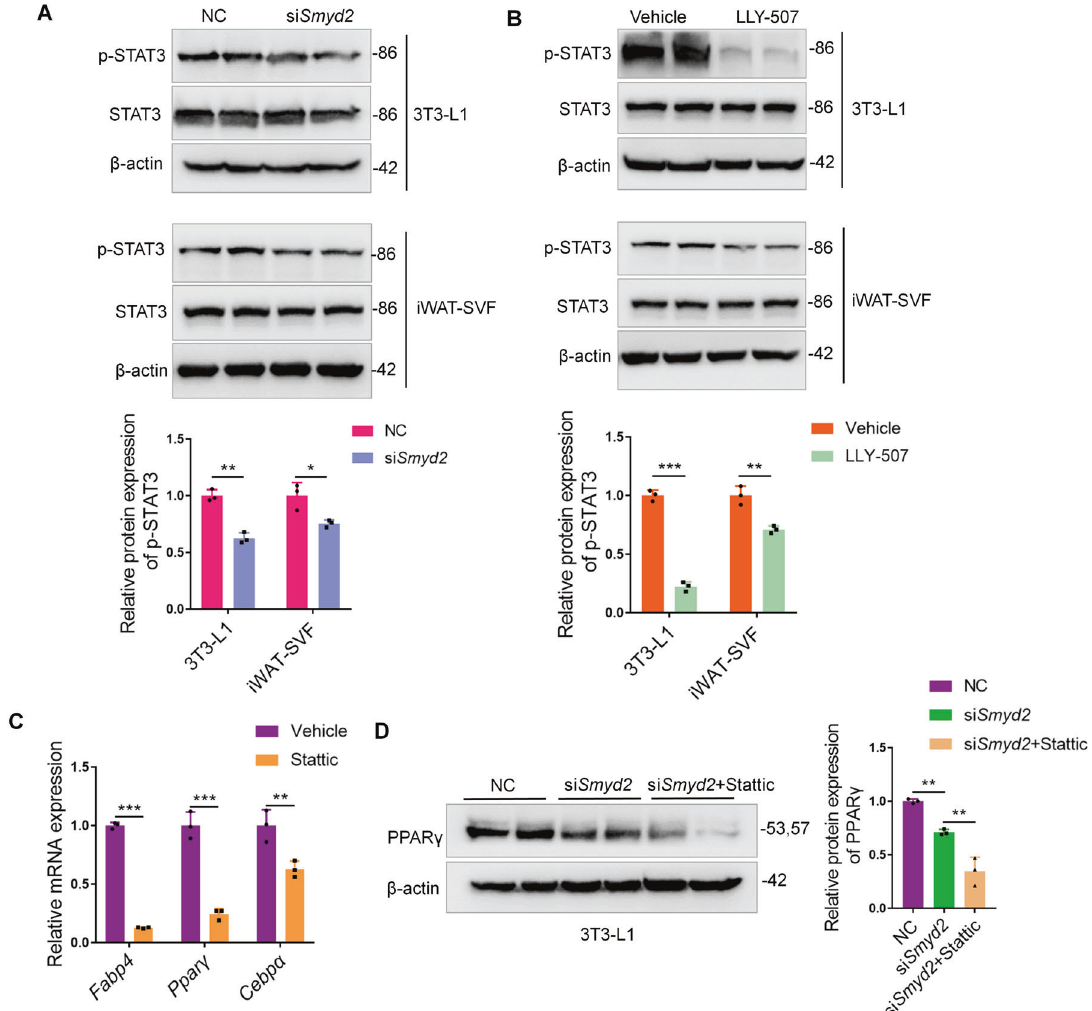
Fig. 5 Smyd2 regulates adipocyte differentiation via phosphorylating STAT3. A, B The phosphorylation levels of STAT3 (Tyr705), as well as the unphosphorylated form, were detected by western blot in either Smyd2 siRNA- or LLY-507-treated 3T3-L1 and iWAT-SVF adipocytes. C The RT-qPCR analysis of the adipogenesis marker genes ( Ppar γ , Cepb α , and Fabp4 ) in Stattic (5 μ M)-treated 3T3-L1 adipocytes. D The PPAR γ protein expression was detected by western blot upon Smyd2 siRNA transfection or Smyd2 siRNA in combination with Stattic (5 μ M) treatment. Data are presented as mean ± SD. * p < 0.05, ** p < 0.01, *** p <